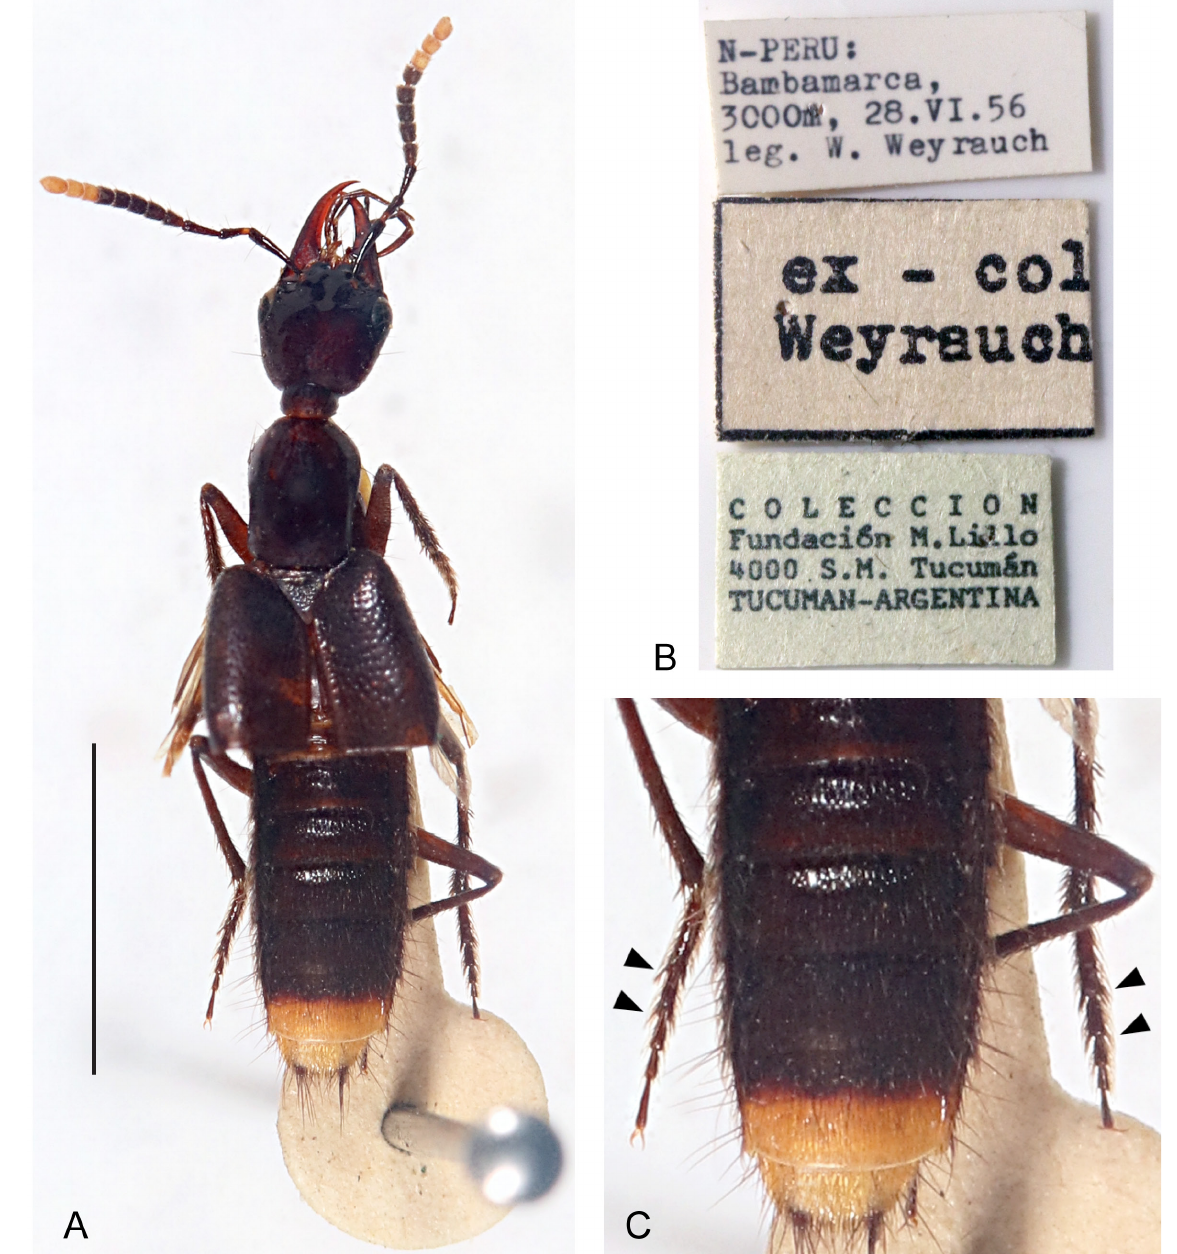
Fig. 3. Ophionthus asenjoi sp. nov. Holotype, ♀ (IFML). A . Habitus, dorsal view. B . Original labels. C . Metatarsomeres 1 and 2 with strong and distinct marginal setae (arrows). Scale bar = 5